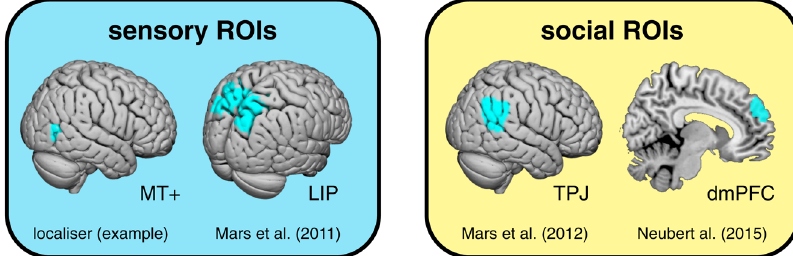
Fig. 5 Anatomical masks for ROI analyses. The MT + mask was speci fi ed for each participant using a localiser scan. The other masks were speci fi ed using published connectivity-based parcellation atlases (see